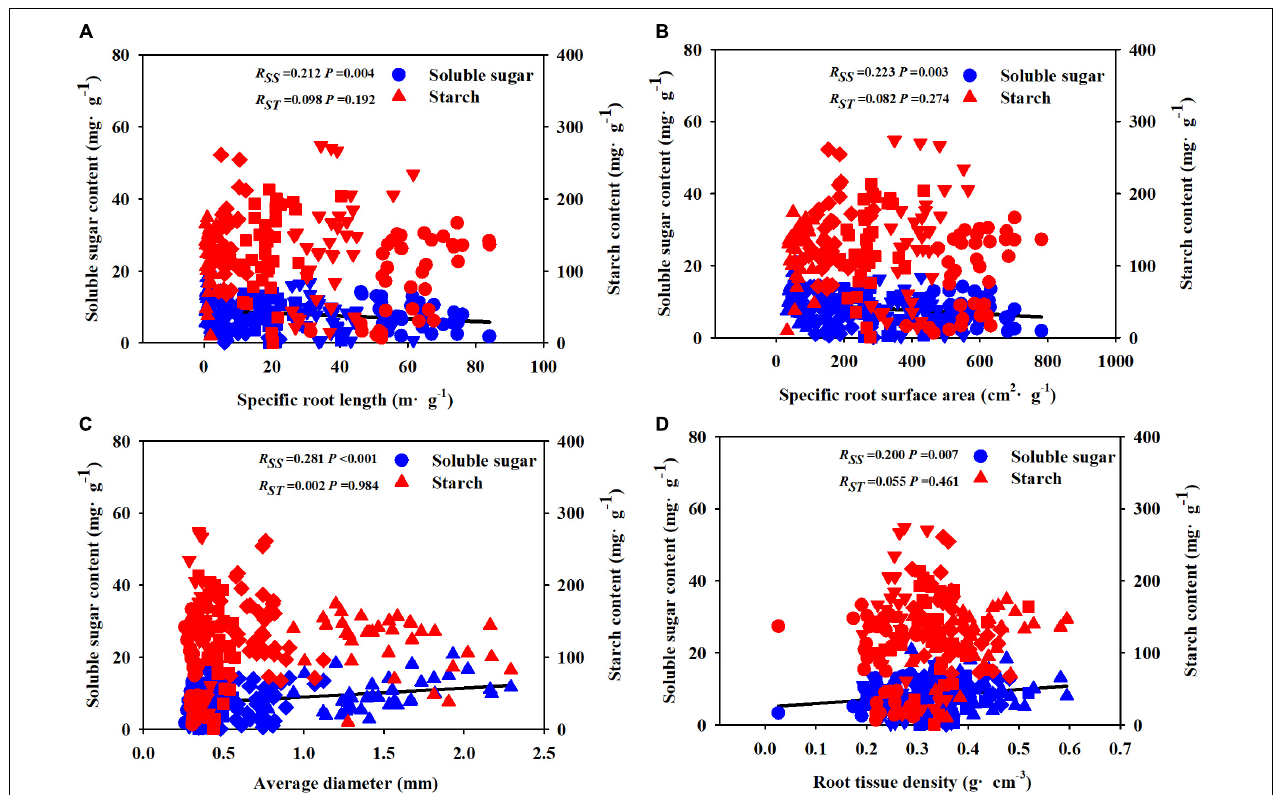
FIGURE 6 | Relationships between soluble sugar, starch concentration, and fine root morphological traits [SRL (A) , SRA (B) , AD (C) , and RTD (D) ] during the whole experiment period. R: correlation coefficient; SS: soluble sugar; ST: starch; SRL: specific root length; SRA: specific root surface area; AD: average diameter; RTD: root tissue density; circle represents 1st-order root; down-triangle represents 2nd-order root; square represents 3rd-order root; diamond represents 4th-order root; up-triangle represents 5th-order